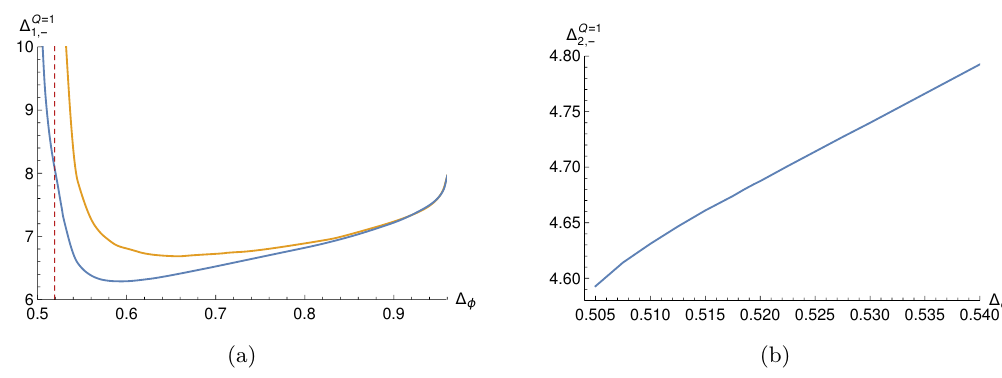
Figure 9 . On the left: bound on the dimension of the first charge-1 parity-odd spin-1 operator as a function of ∆ φ . The dashed red line corresponds to the value of ∆ φ of the O (2) model. The two lines corresponds to different gaps in the charge-1 spin-2 parity-odd sector to remove the fake primary effect. On the right: bound on the dimension of the first charge-1 spin-2 parity-even operator as a function of ∆ φ . When the bound reaches 5 it jumps to a much higher value. The bounds have been obtained at Λ = 13